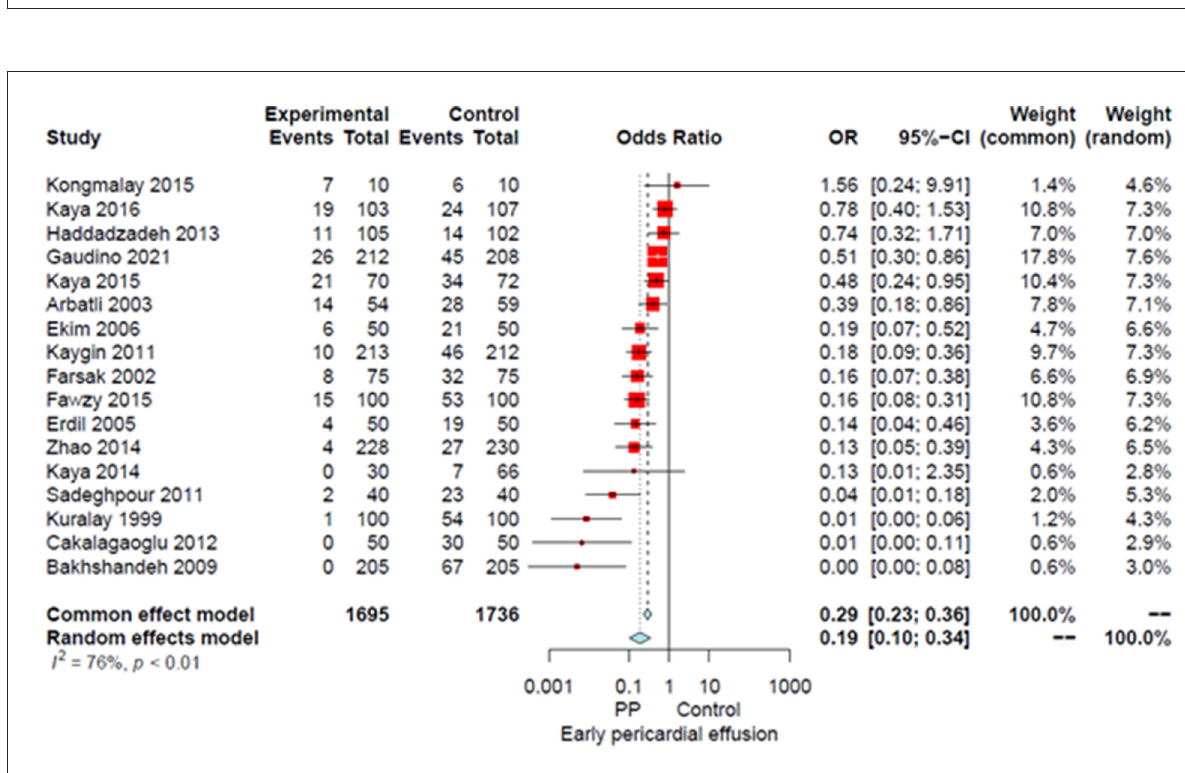
FIGURE2 Forest plot for early pericardial effusion. CI, confidence interval; OR, odds ratio; PP, posterior